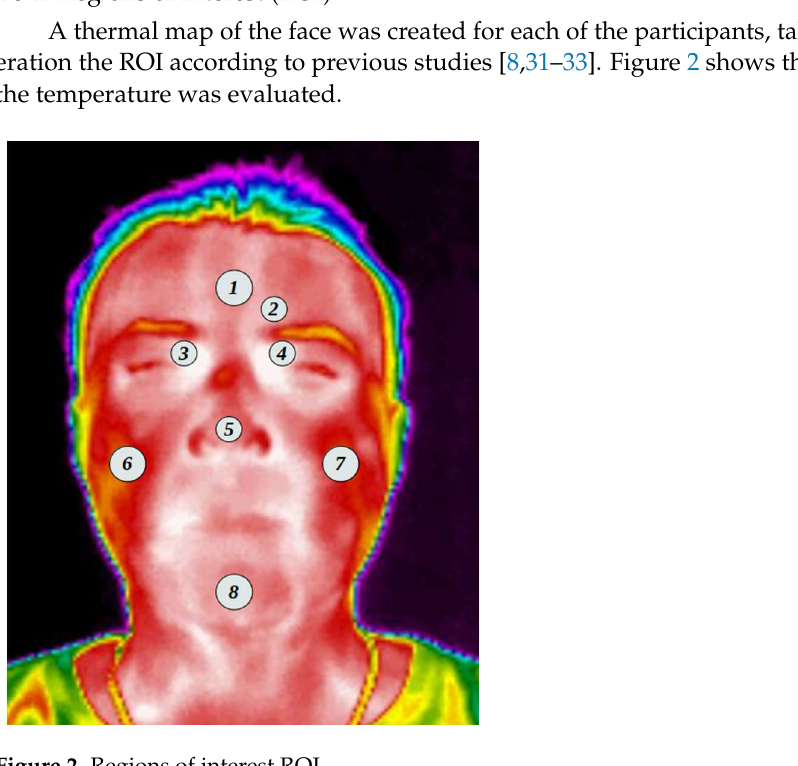
Figure 2. Regions of interest